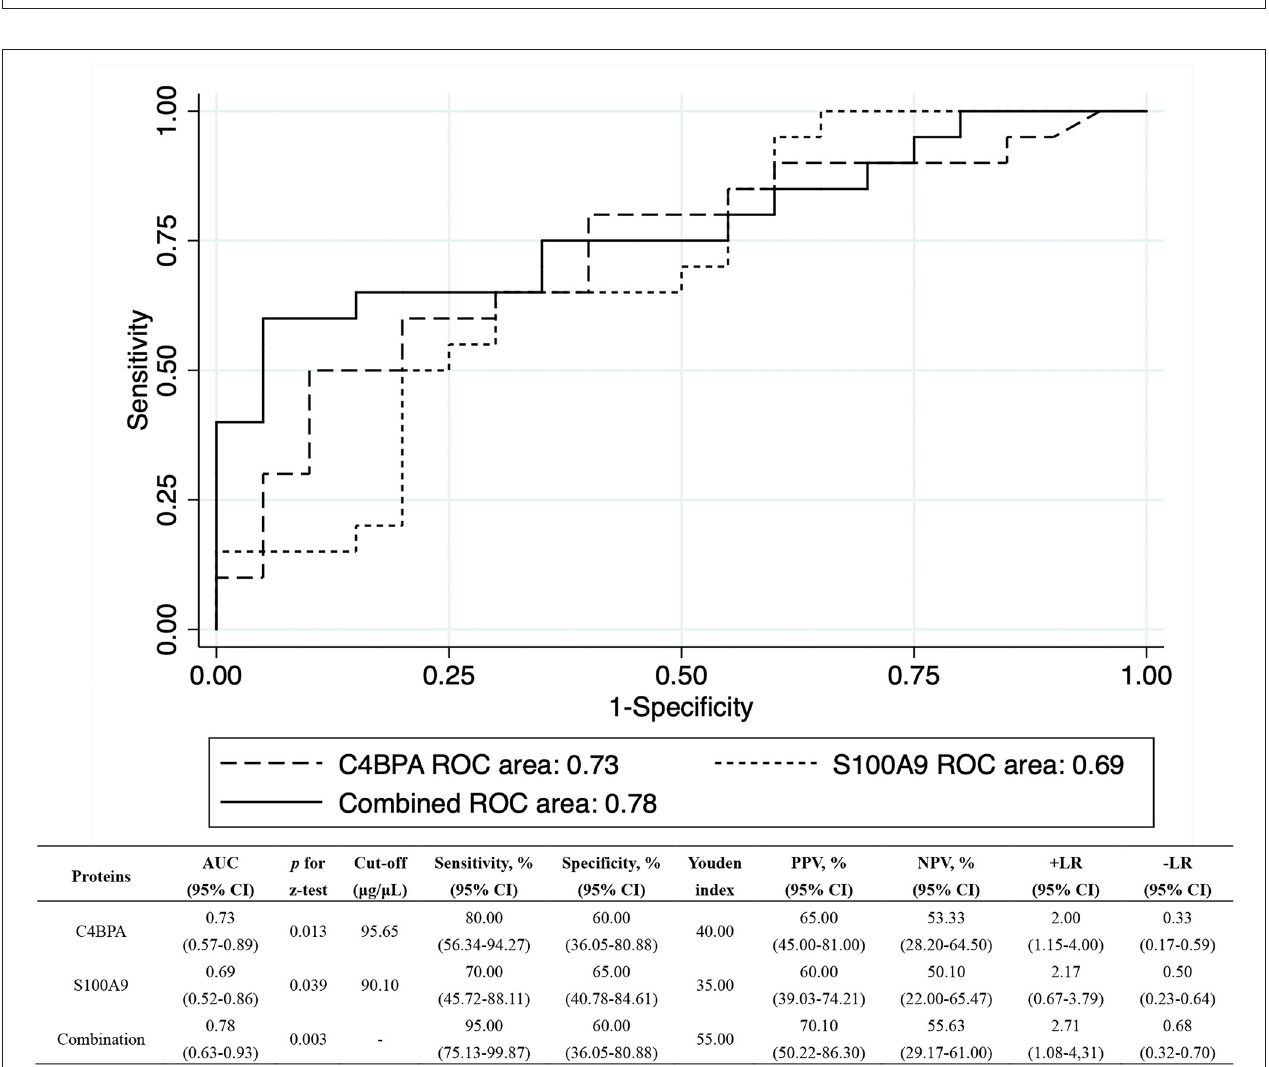
FIGURE 2 | molecular function (MF). (B) Kyoto Encyclopedia of Genes and Genomes (KEGG) classification and pathway analysis of 9 identified differentially expressed proteins. Bar chart representing the classification of enriched KEGG pathways. The scattered plot showed the top 30 of pathway enrichment. The X-axis indicates the rich factor; Y-axis indicates the name of the KEGG pathway. The dot size means the protein number and the dot color indicates the p -value. (C) String.org protein–protein interaction network for C4BPA and S100A9. Light blue line, known interaction from curated database, pink line, known interaction experimentally tested; dark blue line, gene co-occurrence; dark green line, predicted gene neighborhood; light green line, text mining interaction source; black line, co-expression interaction source; light purple line, protein homology interaction source. BP, biological process; CC, cellular component; GO, gene ontology; KEGG, Kyoto encyclopedia of genes and genomes; MF, molecular function.